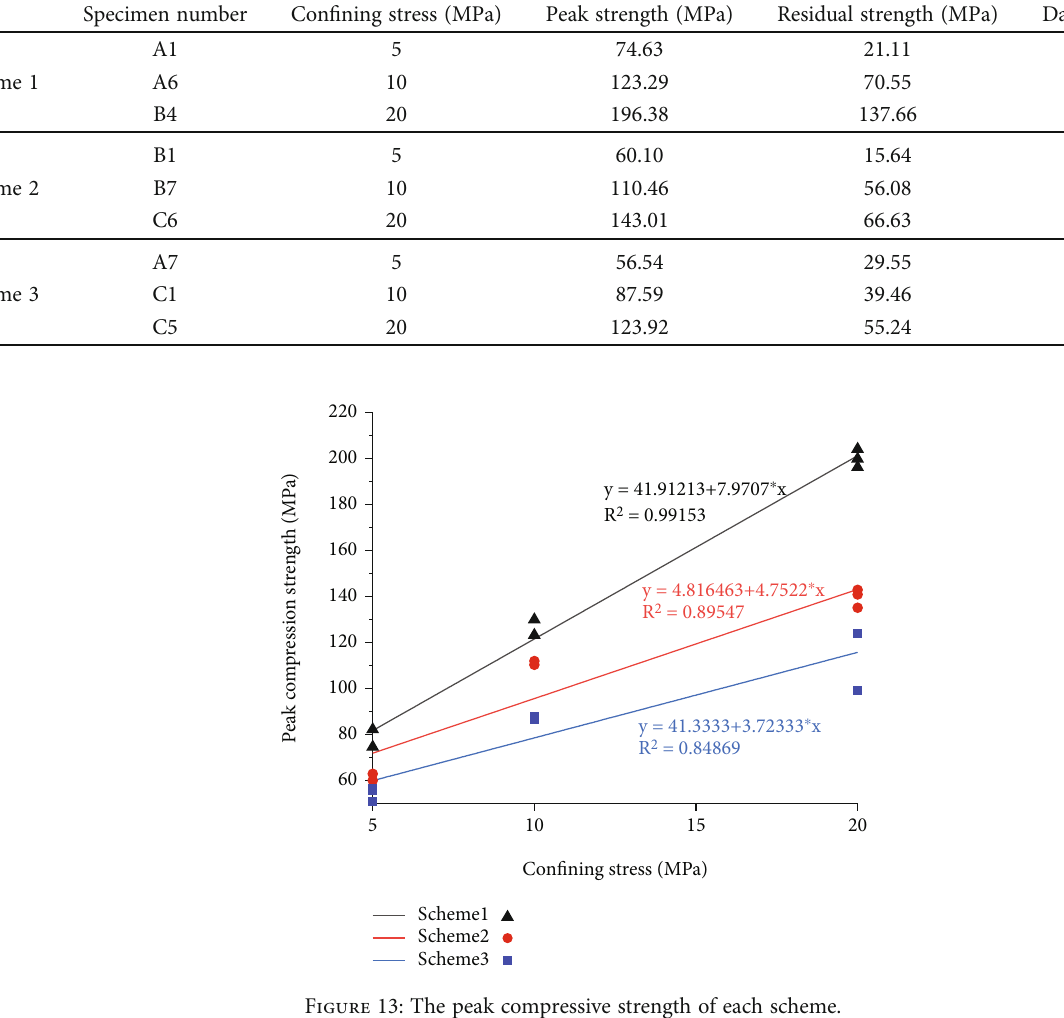
Table 3: The mechanics and damage characteristic values of each scheme.